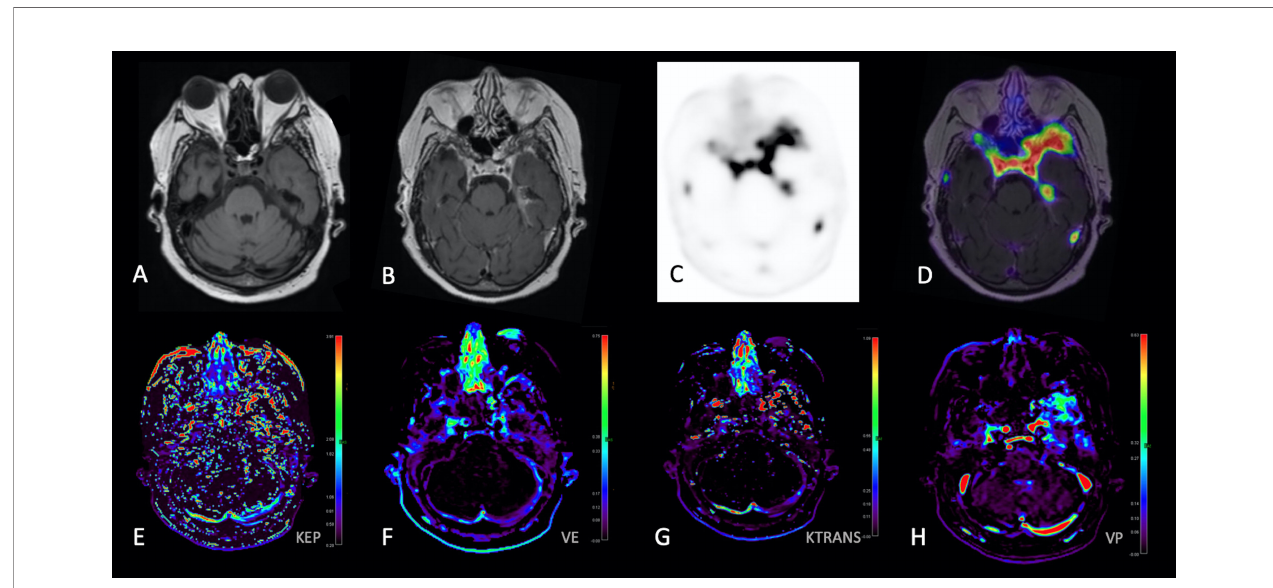
FIGURE 2 | 68-Gallium-DOTATATE PET and DCE Perfusion MRI images in a 68-year-old woman with WHO-1 left anterior temporal convexity meningioma post prior surgical resection and RT. Axial T1-weighted (A) , gadolinium-enhanced axial T1-weighted (B) , static 68-Gallium-DOTATATE PET image (C) , axial PET/MR fusion image (D) , Kep parametric map (E) , Ve parametric map (F) , Ktrans parametric map (G) , and Vp parametric map demonstrates extra-axial homogeneously enhancing soft tissue with corresponding 68-Gallium-DOTATATE avidity [ (D) , with SUV measured along the left anterior temporal convexity] and abnormal perfusion parametric maps (E – H) , corresponding to region of suspected residual/recurrent